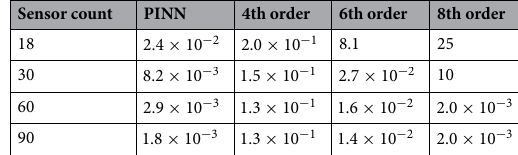
Sensor count PINN 4th order 6th